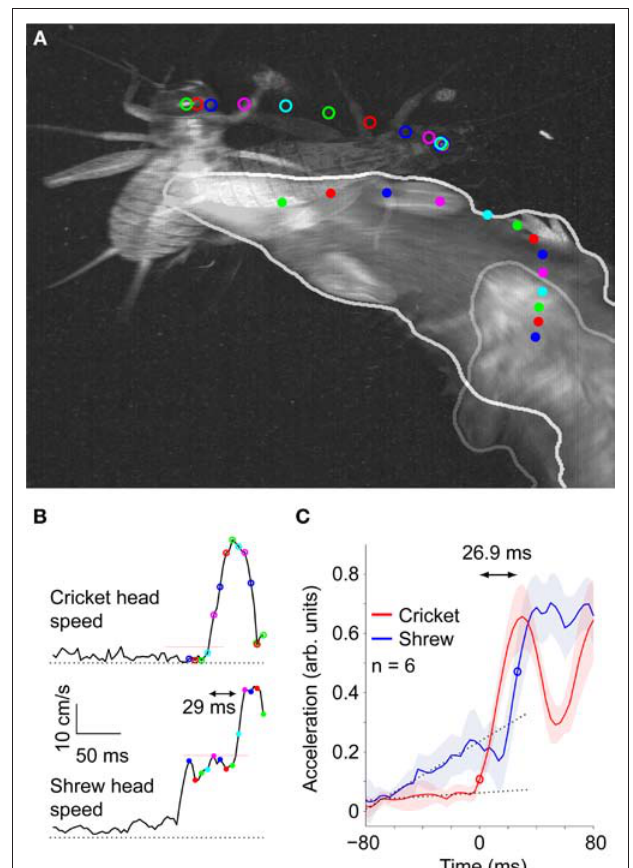
FigurE 6 | Mid-attack change of direction. (A) Still frames from two different time points (time lapse between images = 0.23 s) before and at the end of the attack are overlaid on top of each other. Dots and circles are the head positions of the shrew and cricket, respectively, during the attack. Dots and circles are color coded so that head positions of the shrew and cricket at the same time point can be compared. (B) Head speed of the cricket (top) and shrew (bottom). A 29 ms lapse between the cricket’s speed increase and the shrew’s speed increase. Black dotted lines = 0 cm/s, red-dotted lines represent the thresholds used to determine time of speed increase (3 SD above mean speed preceding the increase). (C) Average of six attacks in which the shrew changed direction in reaction to the cricket. Black dashed lines are linear fits to the baseline acceleration prior to the sudden increase in cricket acceleration (defined as t = 0 ms). Shaded regions represent ± 1 SE. Acceleration was defined to have increased when it went at least one SE above the linear fit to the baseline (red and blue circles). The difference in time between the cricket and shrew acceleration increase was 26.9